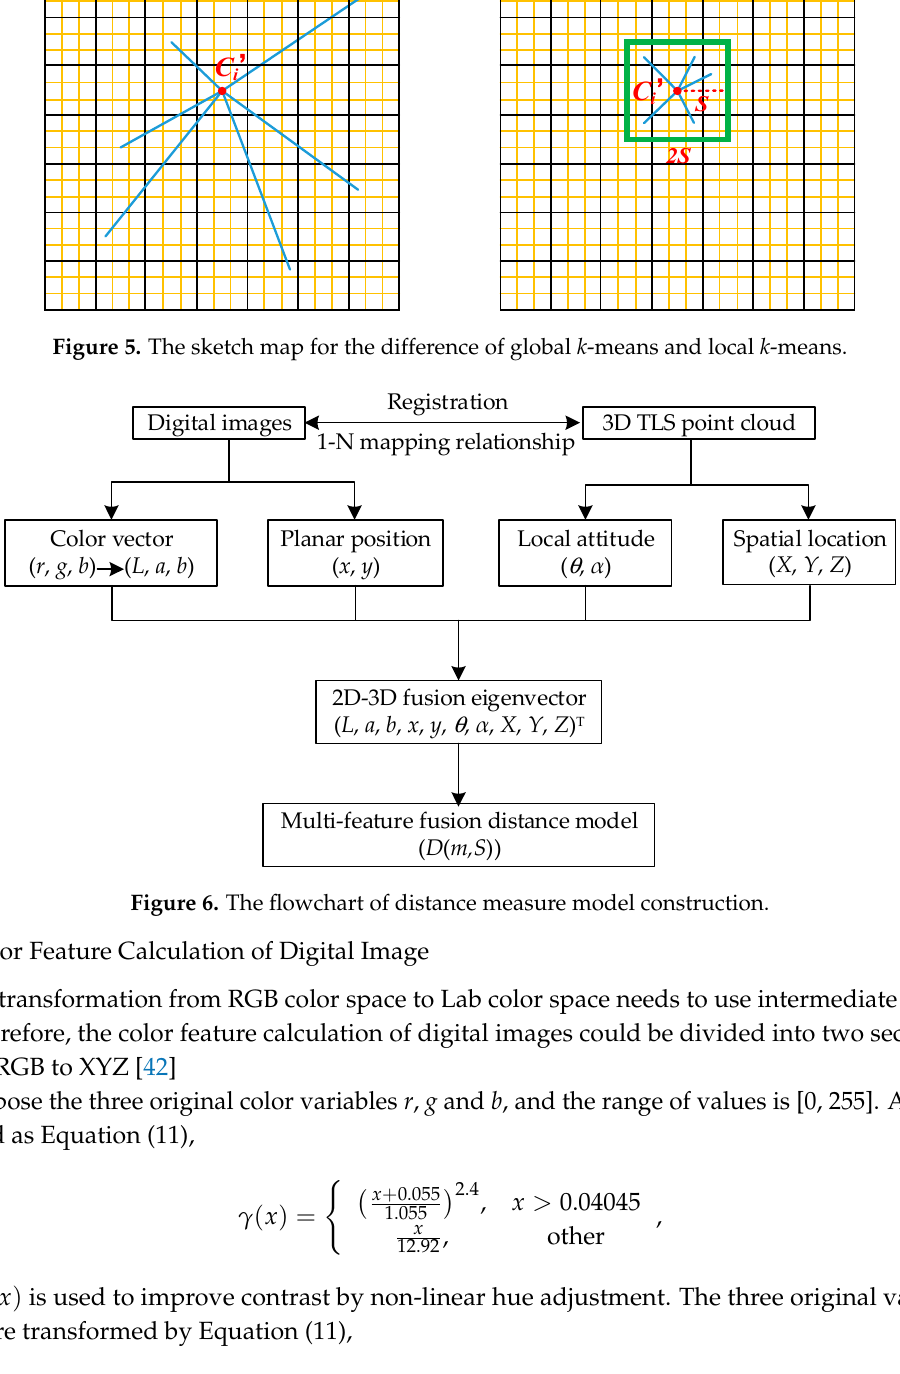
I N Figure 4. The 1- N mapping relationship between the TLS point cloud and digital images. 3.2. Multi-Feature Fusion Distance Measure Model of MFF-SLIC In the initial segmentation stage of MFF-SLIC algorithm, K clustering centers are initialized first, and the distance between each pixel in search area and clustering centers is respectively calculated by multi-feature fusion distance measure model based on a local k -means method, then each pixel